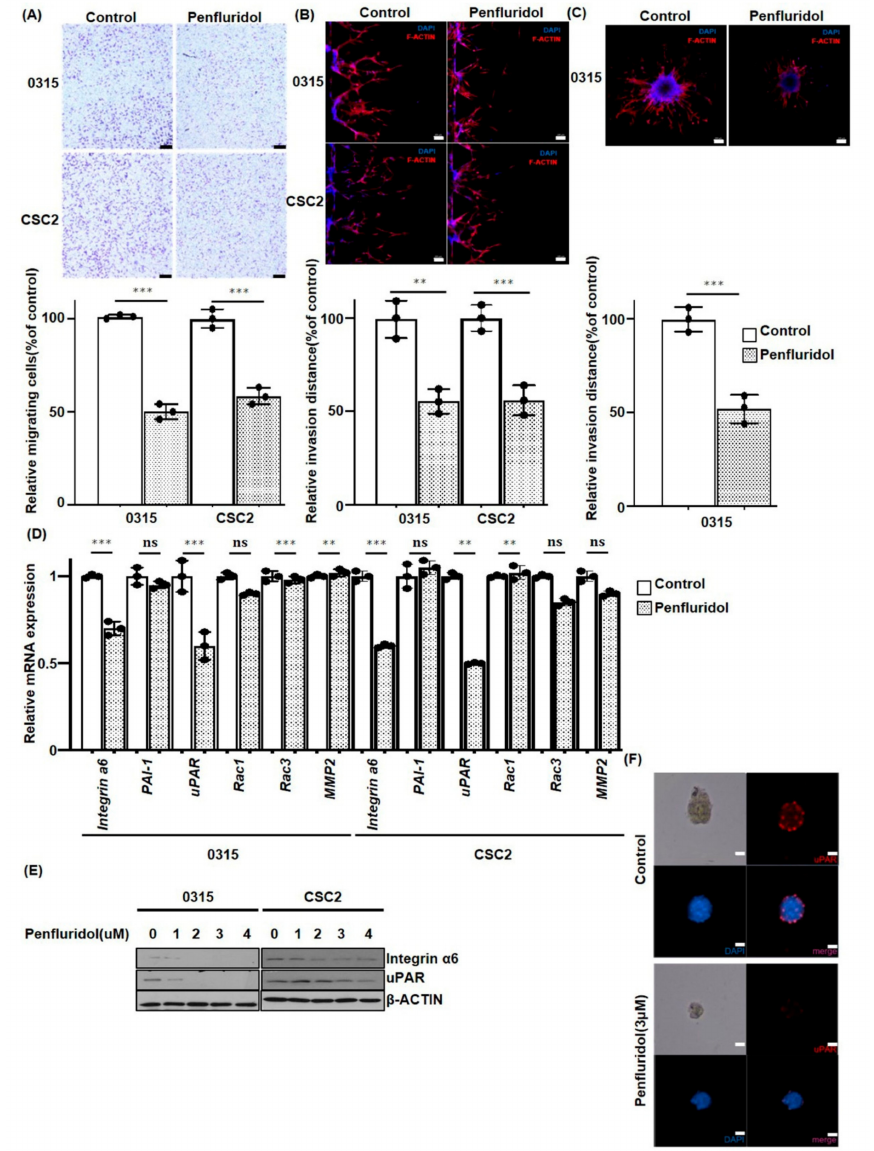
Figure 3. PFD suppresses GSCs migration and invasive potential. ( A ) 0315 and CSC2, highly invasive GSCs, were seeded in the Transwell and treated with 2 µ M PFD. At 24 h, traversed cells were stained and counted (*** p ≤ 0.001). No treatment was used as control. The experiment was repeated three times, and values are plotted as mean ± SD (Scale bar: 100 µ m). ( B ) 0315 and CSC2 GSCs were attached to the microfluidic device and treated with 2 µ M PFD. Cells invading the other channel were stained with F-actin and counted at 48 h. Invading cells in PFD treatment group were compared with control (** p ≤ 0.01, *** p < 0.001). The experiment was repeated three times, and values were plotted as mean ± SD (Scale bar: 100 µ m). ( C ) For 3D invasion assay from a GSC spheroid in the microfluidic device, 0315 GSCs were treated with 2 µ M PFD. At 72 h, invaded spheroids were stained with F-actin, and calculated in comparison to the control (*** p < 0.001). Experiment was repeated three times, and values are plotted as mean ± SD (Scale bar: 100 µ m). ( D ) RT-qPCR for Integrin α 6, PAI-1, uPAR, Rac1, Rac3, and MMP2 at 24 h after 2 µ M PFD treatment, and ( E ) Western blotting analyses of Integrin α 6 and uPAR in CSC2 and 0315 cells. GAPDH or β -actin were used as loading control. Data are presented as the mean ± SD of triplicate qPCR assays (ns, no significance; ** p < 0.01, *** p < 0.001, when compared with no treatment). ( F ) Immunocytochemistry for uPAR in CSC2 cells with 3 µ M PFD treatment at 48 h (blue, nucleus; red, uPAR, Scale bar: 100 µ